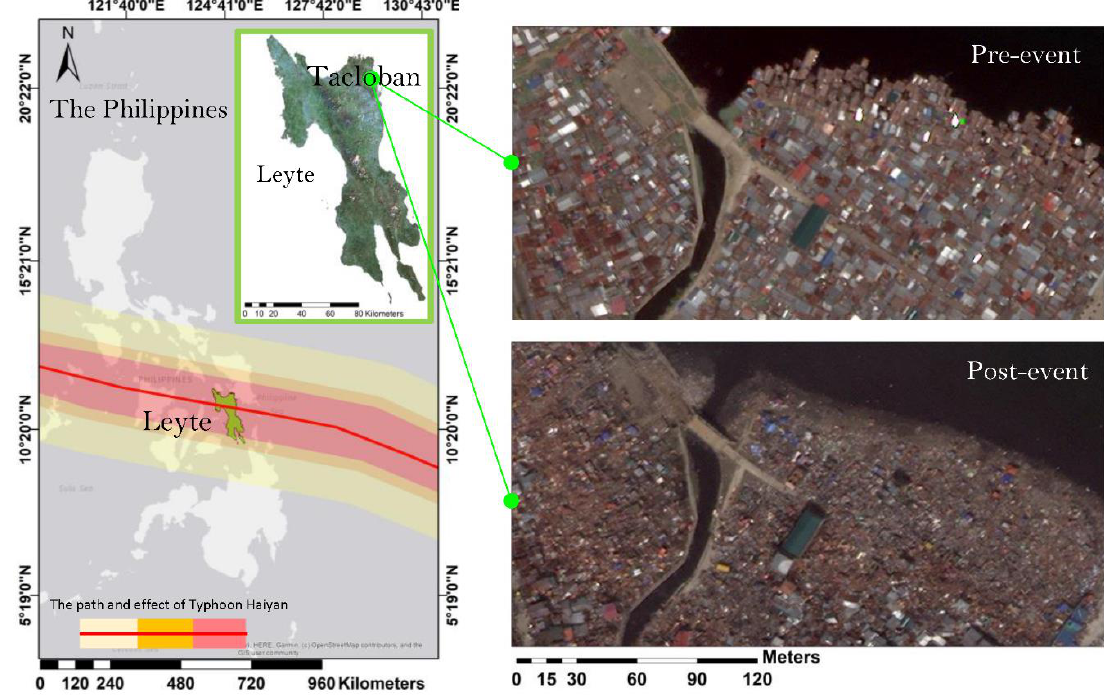
Figure 1. An overview of the Philippines showing the path of Typhoon Haiyan and the location of Leyte island. Pre-event image and an image acquired three days after the disaster for Tacloban.